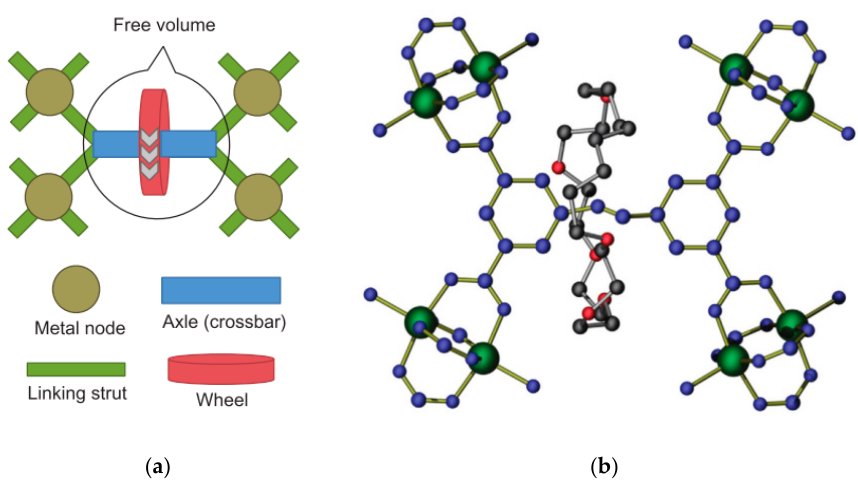
Figure 13. ( a ) Illustration of the composition of a metal–organic rotaxane framework (MORF); ( b ) Crystal structure of the Cu(II) MORF with a [2]rotaxane. Reproduced with permission from [45]. Copyright Nature Publishing Group, 2012.